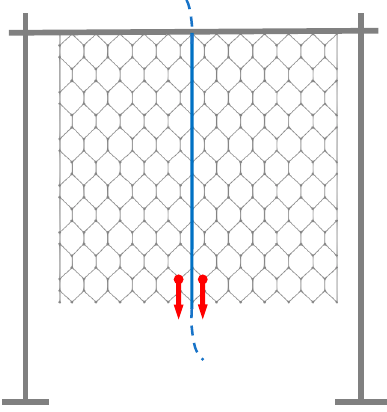
Figure 5. Experimental test setup—second session: the OF cable is integrated in the DTWM.